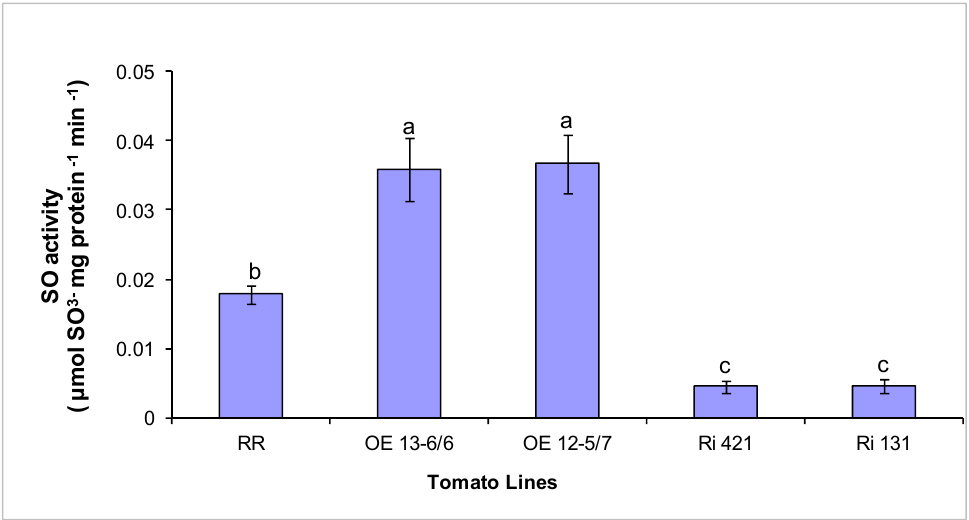
Figure 3. SO enzyme activity in wild type and SO modified tomato lines. Wild type (RR), SO OE (OE 13-6/6 and OE 12-5/7) and SO Ri (Ri 421 and Ri 131) lines were analyzed for SO enzyme activity using 10 µg of crude protein per assay. Values are means ± SE ( n = 8–12). Means denoted with different letters were significantly different ( p < 0.001). The presented data show one of the two experiments that yielded essentially identical results.